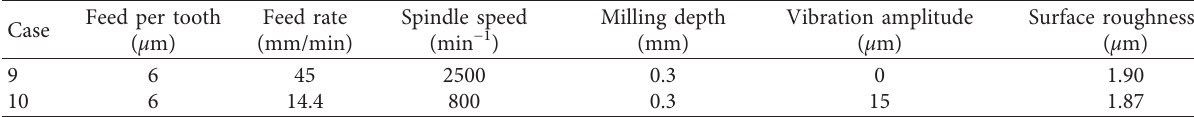
Figure 22: 3D topography contrast of workpiece surface. (a) UVARM. (b) CC. Table 6: Experimental data (sequel).